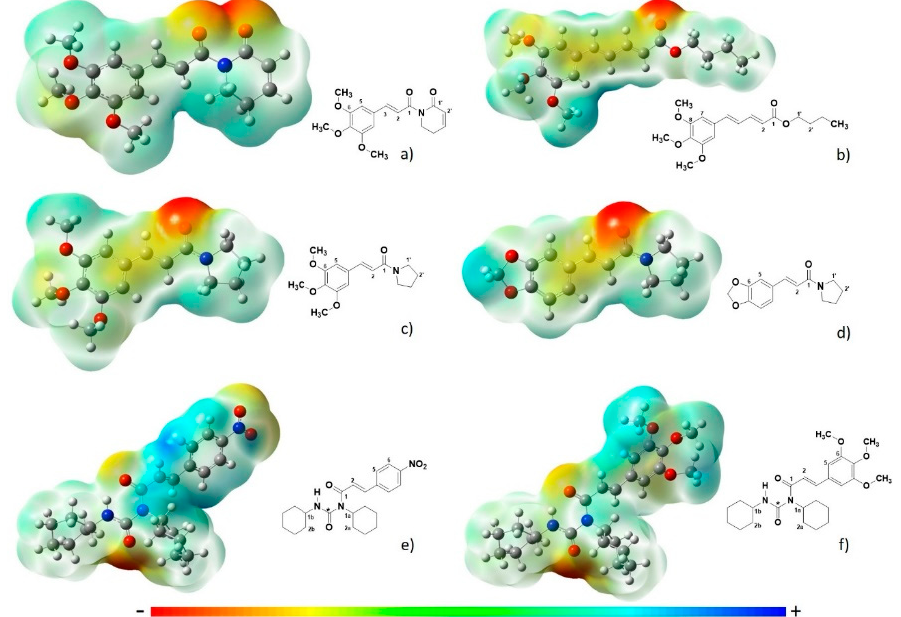
Figure 1. Electron density: ( a ) piplartine; ( b ) 19A; ( c ) 1G; ( d ) 14B; ( e ) 6B and ( f ) 1M. The colours represent negative (red) and positive (blue). The dipole moments of all compounds in debye values are as follows: piplartine: 5.4728337; 1G: 1.9658996; 1M: 4.4568136; 6B: 4.0062111; 14B: 3.9403826; 19A: 3.7385640.